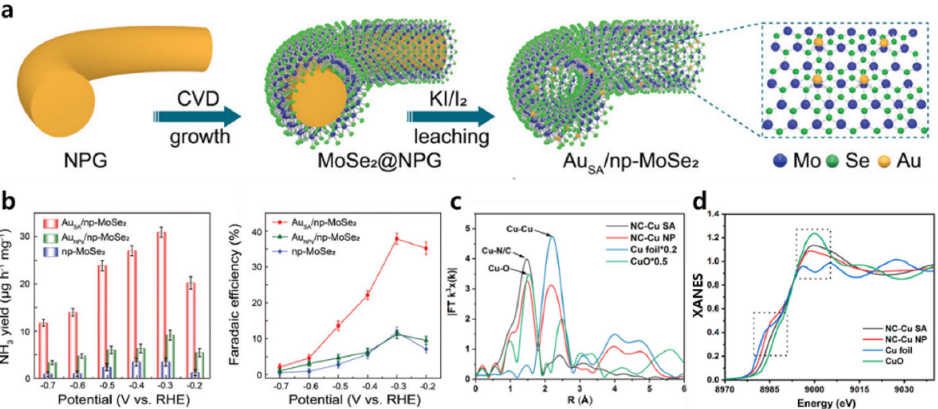
Figure 4. ( a ) Schematic illustration of Au SA /np-MoSe 2 preparation process. ( b ) NH 3 production rates (NH 3 yield rates) and FEs of Au SA /np-MoSe 2 , Au NPs /np-MoSe 2 and np-MoSe 2. Reproduced with permission [46]. Copyright 2021, Wiley–VCH. ( c ) EXAFS and ( d ) XANES spectra of NC-Cu SA, NC-Cu NP, Cu foil, and CuO. Reproduced with permission [48]. Copyright 2019, American Chemical